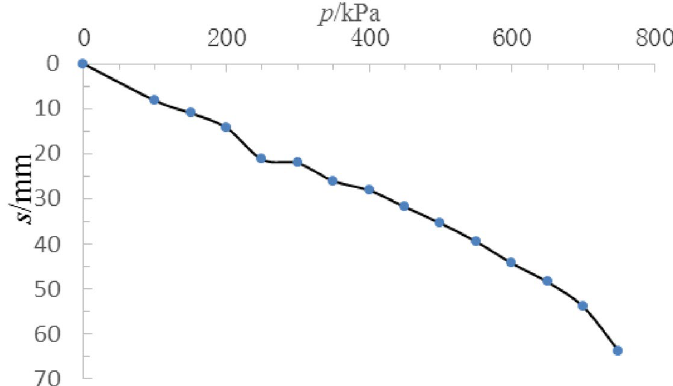
Figure 10. p – s curve of the composite